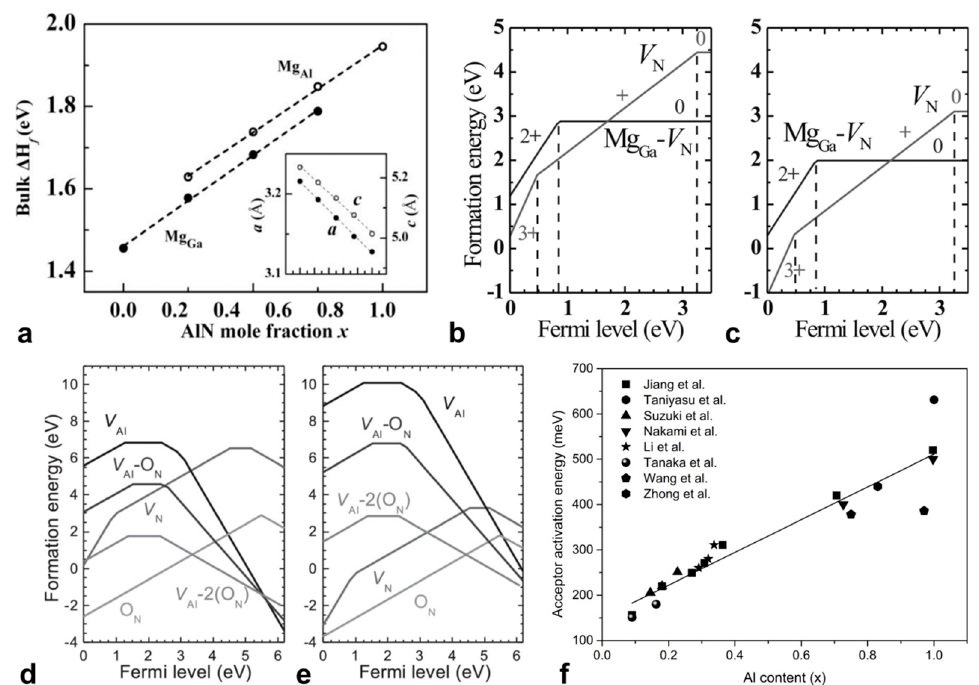
Figure 8. ( a ) Formation enthalpies of Mg Ga /Mg Al in the bulk AlGaN as a function of Al content under N-rich condition [100]. Formation energies as a function of Fermi level for the V N and the Mg Ga –V N complex in GaN, under ( b ) N-rich and ( c ) Ga-rich conditions [102]. Formation energies as a function of Fermi level for the V N , V Al , O N , V Al − O N and V Al − 2(O N ) in AlN, under ( d ) N-rich and ( e ) Al-rich conditions [103]. ( f ) The activation energy of Mg in Al x Ga 1 − x N in dependence of Al mole fraction x, data extracted from [ Error! Reference source not found. , Error! Reference source not found. ].